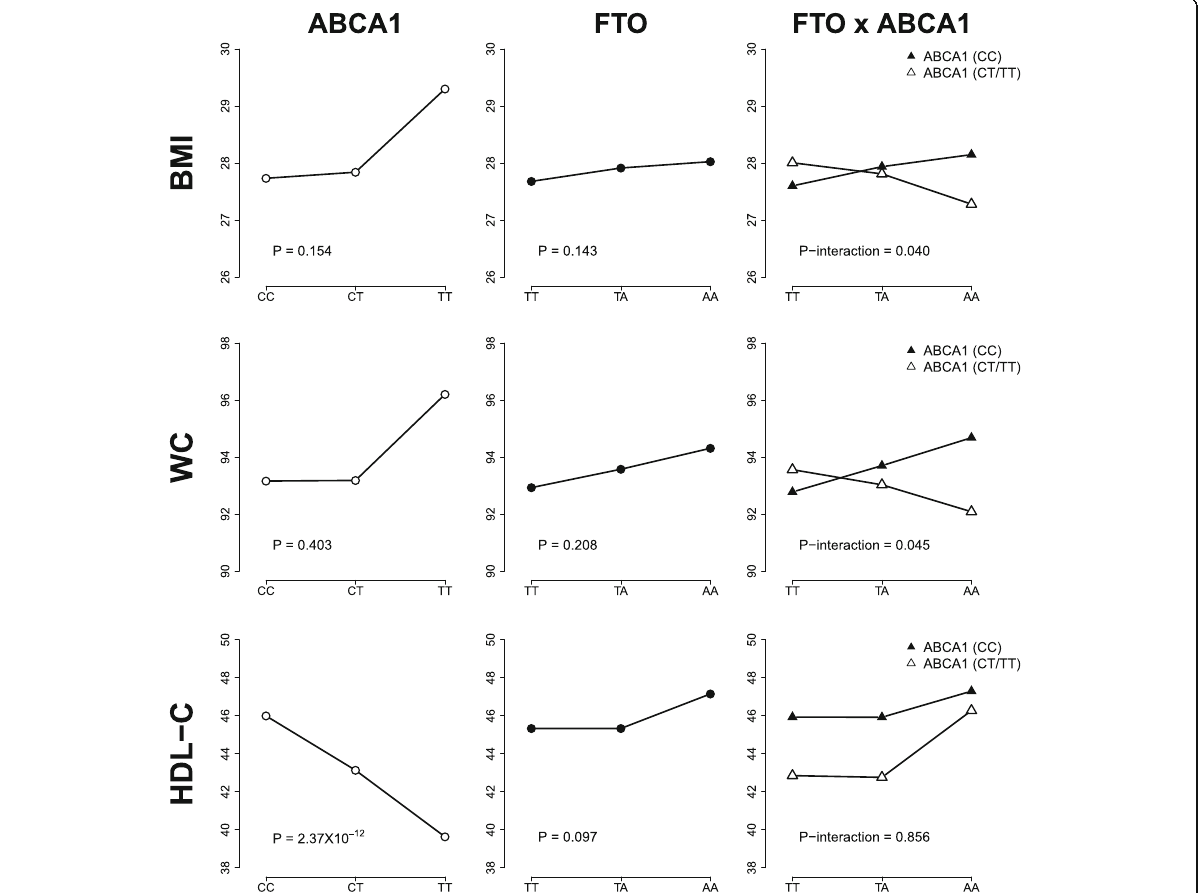
Fig. 1 Association of FTO rs9939609 and ABCA1 rs9282541 risk variants, independently and stratified, with BMI, waist circumference (WC) and HDL-cholesterol (HDL-C) levels, adjusting for age, gender and BMI as